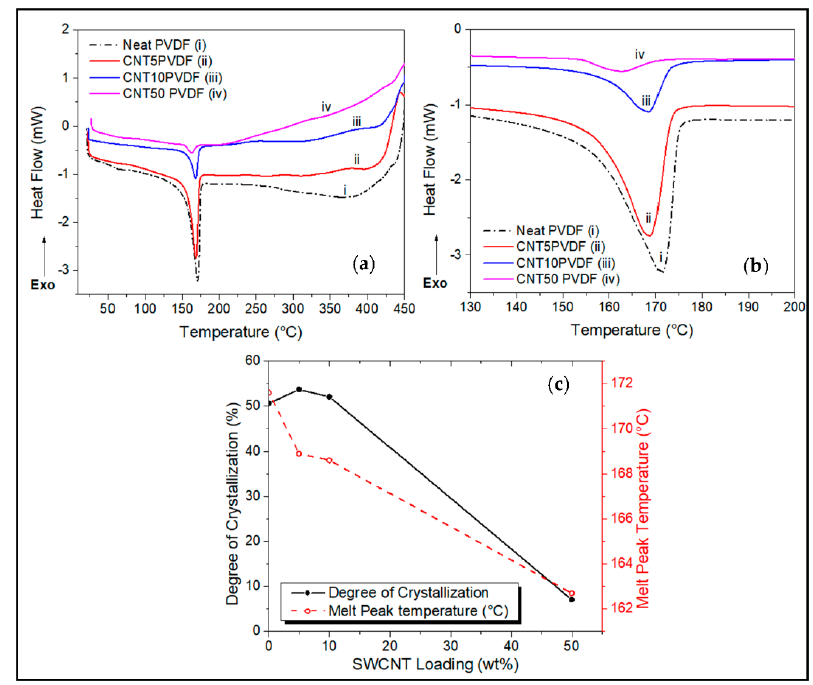
Figure 3. DSC comparisons of ( a ) CNT wt.% loadings on PVDF, showing ( b ) endothermic melting peaks carried out under N 2 atmosphere. ( c ) Degree of crystallization and melt peak temperature trend with